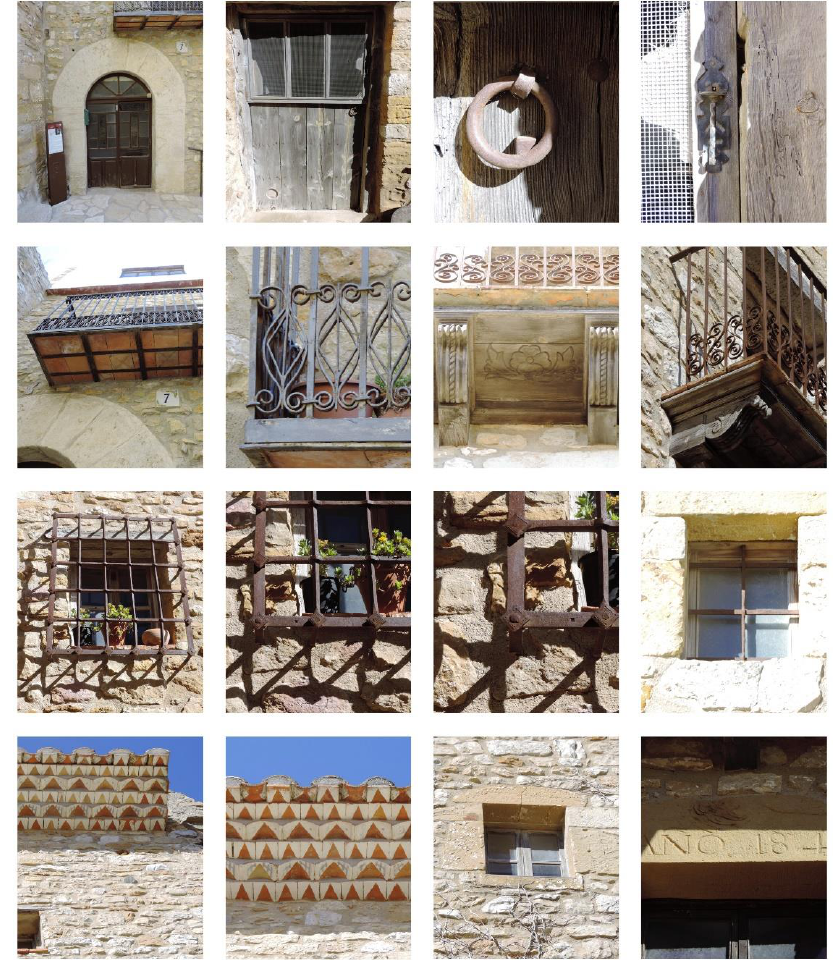
Figure 1. A collection of tangible street elements linked to arts and crafts: Historical, Cultural and Tangible values in Tables 2 and 3. Phase 1 of the research (2020). Source: Author.